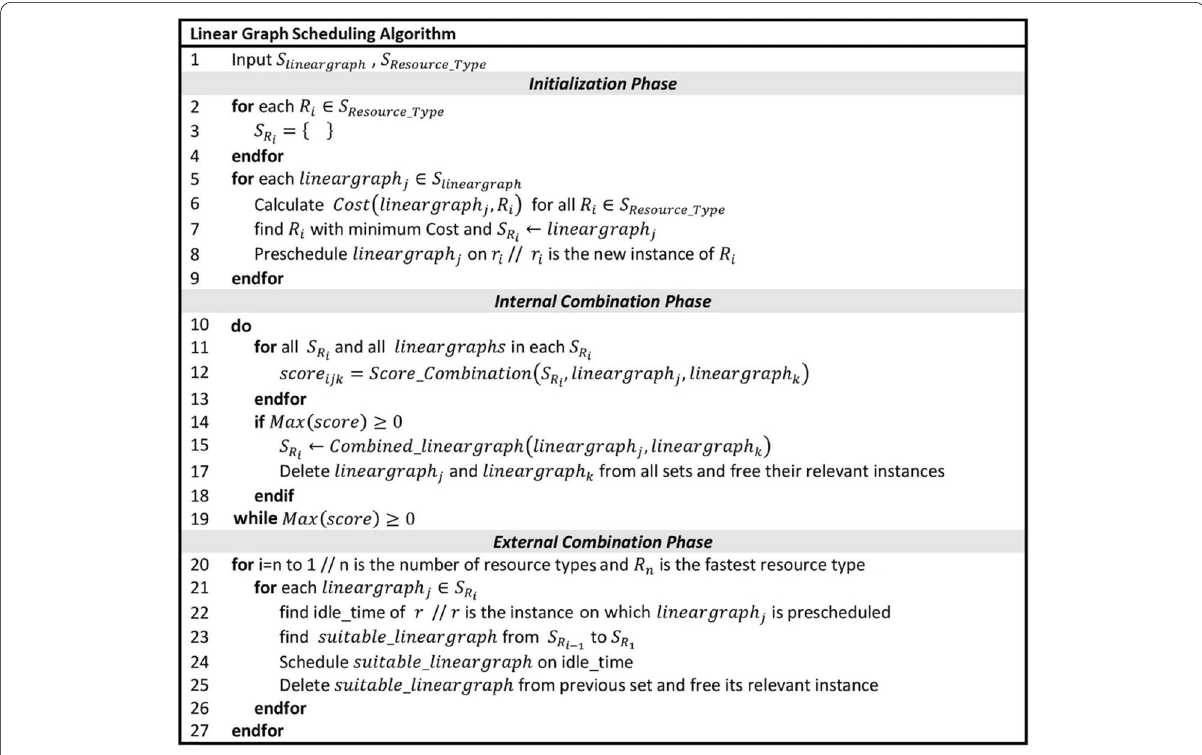
Fig. 7 Linear graph scheduling